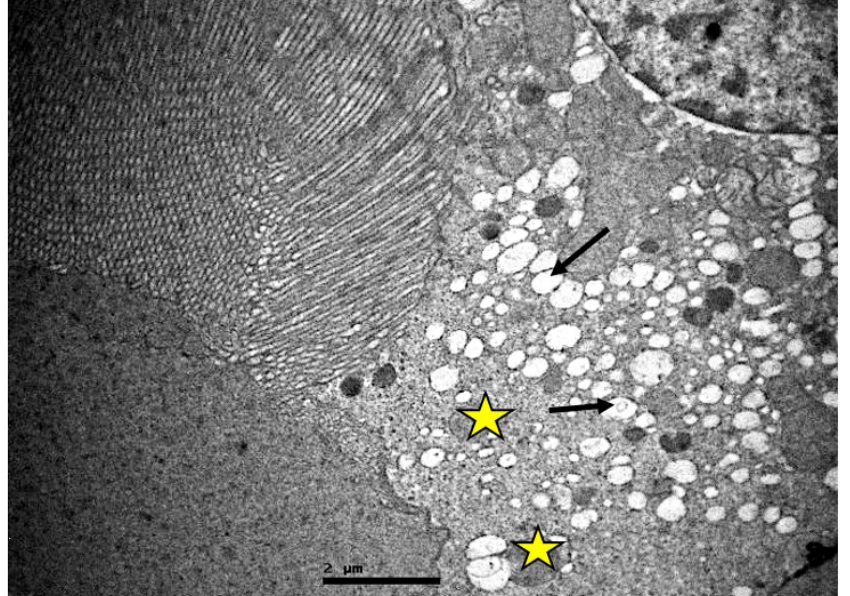
Figure 13. Renal convoluted tubules of non-resuscitated swine sample. Within the cell are identified large vacuolar spaces (black arrows) and swollen mitochondria (yellow stars). The basement membrane of the tubular epithelium was thickened. Moreover, the presence of intracellular vacuoles, enlarged mitochondria, and a plethora of apoptotic cells (Figure 14) were observed.